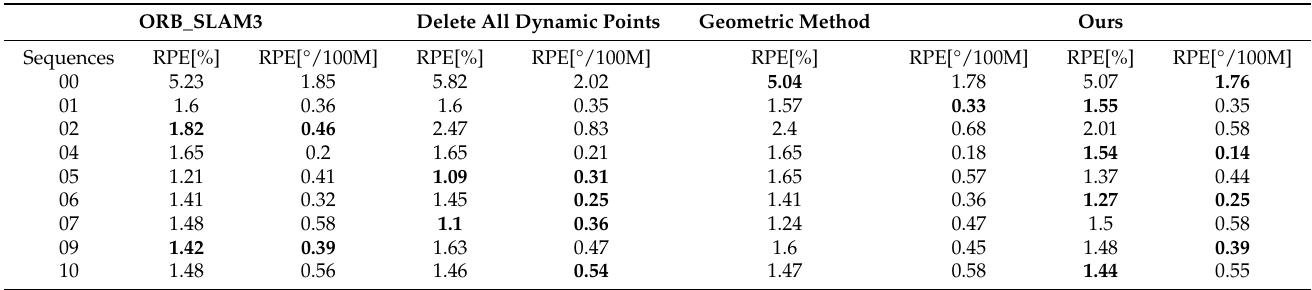
Table 7. The relative positional error of the original algorithm, the algorithm of removing all feature points falling in the bounding box, the geometric method using RANSAC, and the improvement algorithm(with Sim(3) Umeyama alignment), while processing panning rotation and scale.